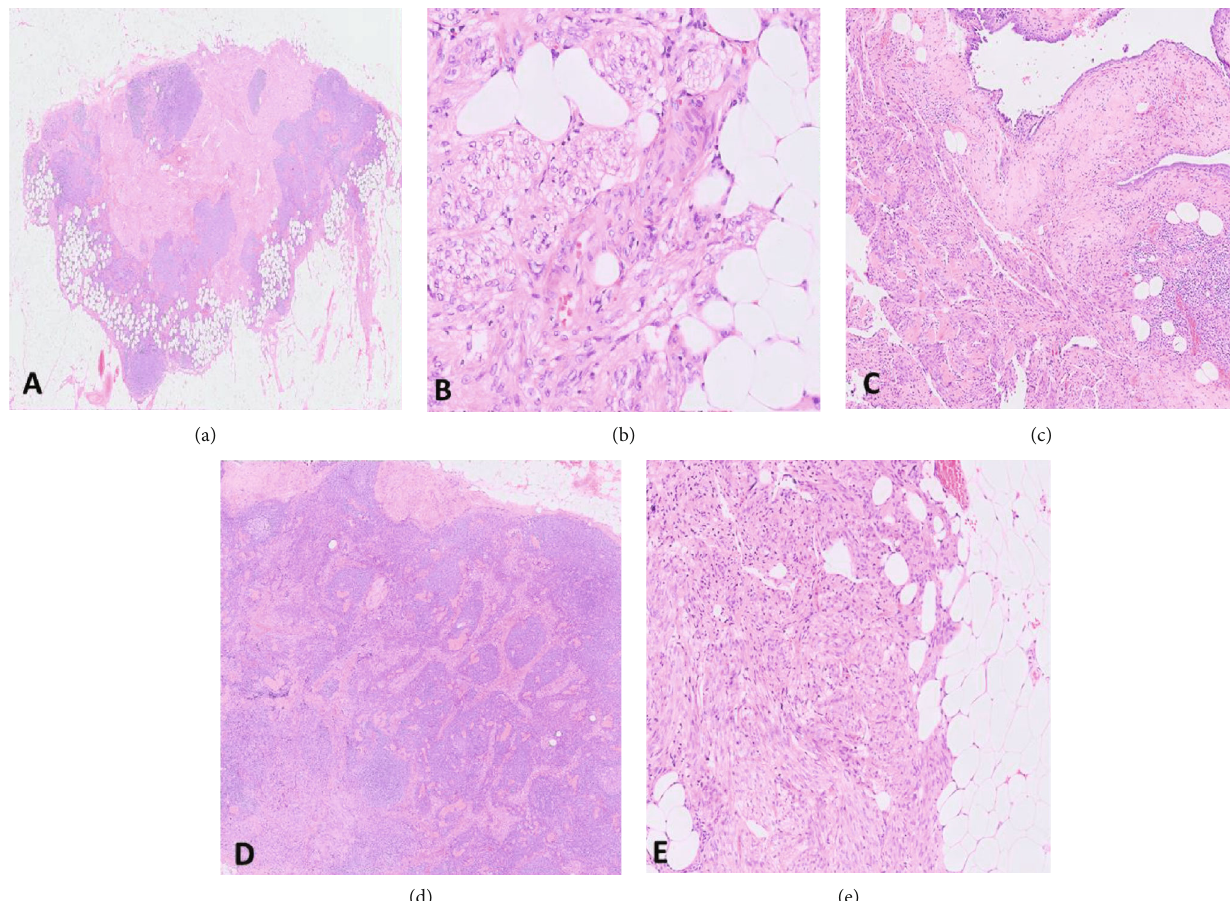
Figure 1: Histology showing (a) lymph node (H&E, 4x) involved by a lesion containing (b) fascicles resembling smooth muscle (H&E, 60x) with associated (c) endometriosis (H&E, 20x) and (d) adjacent foci of metastatic serous carcinoma (H&E, 20x). (e) Similar spindle cell bundles were also present in the perinodal adipose tissue (H&E,